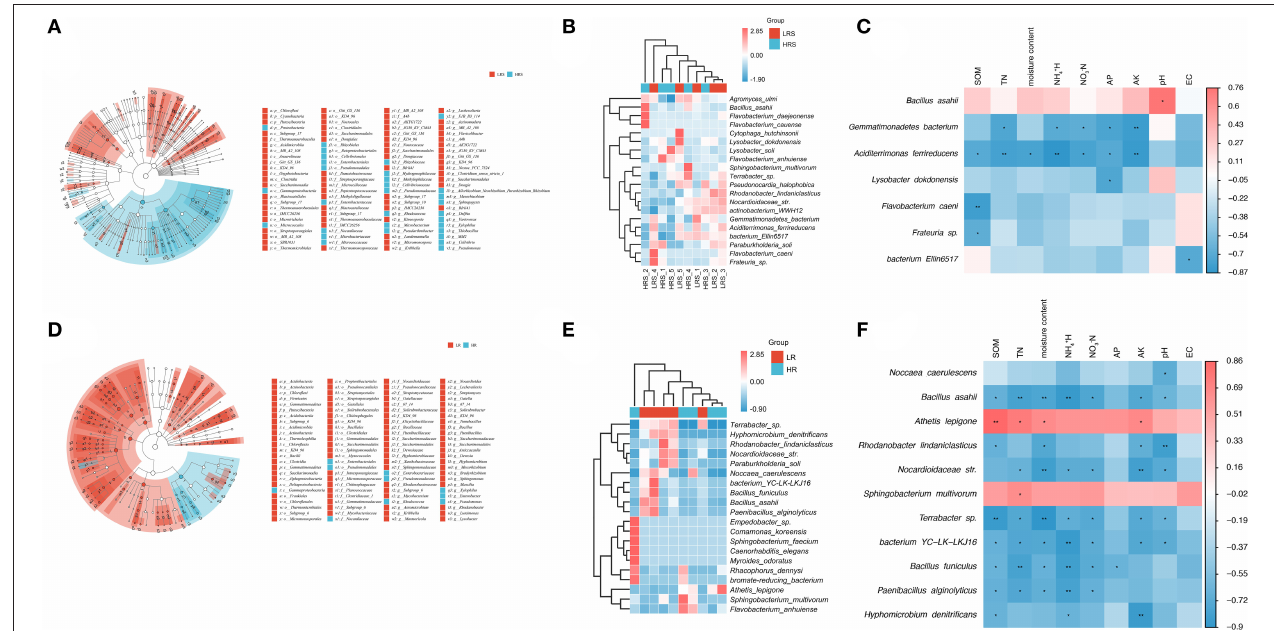
FIGURE 5 | (A–C) Significant differential bacterial taxa (A) and species (B) between the LR and HR soil. The correlation of abundant bacteria in the HR soil with soil physicochemical properties was evaluated with Pearson’s correlation analysis (C) . (D,E) Significant differential taxa (D) and genus (E) between the LR and HR cabbage roots. The correlation of abundant bacteria in the HR roots with soil physicochemical properties was evaluated with Pearson’s correlation analysis (F) . Different colors represent the different samples (A,D) , abundance (B,E) , or correlations (C,F) . * p < 0.05, ** p <